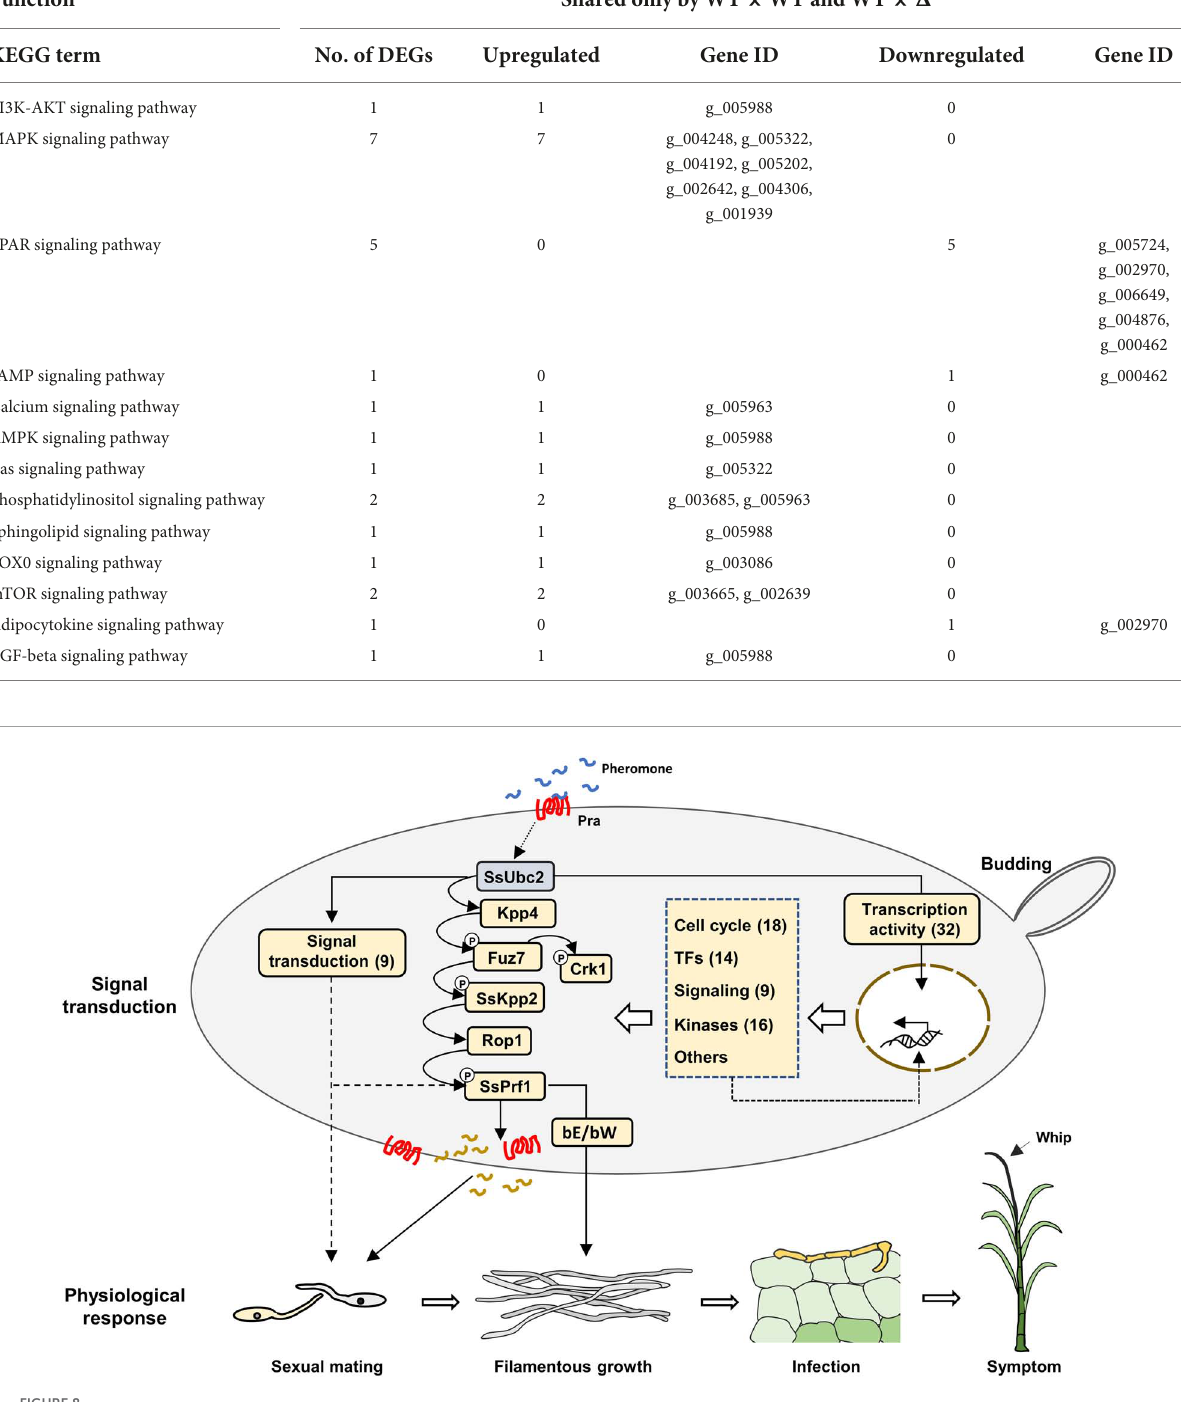
FIGURE8 Proposed working model of SsUbc2 in S. scitamineum . SsUbc2 functions as a coordinator to orchestrate the transcriptome of the fungus by regulating key transcription factors that have a global impact on the transcriptome. More secondary transcription factors, protein